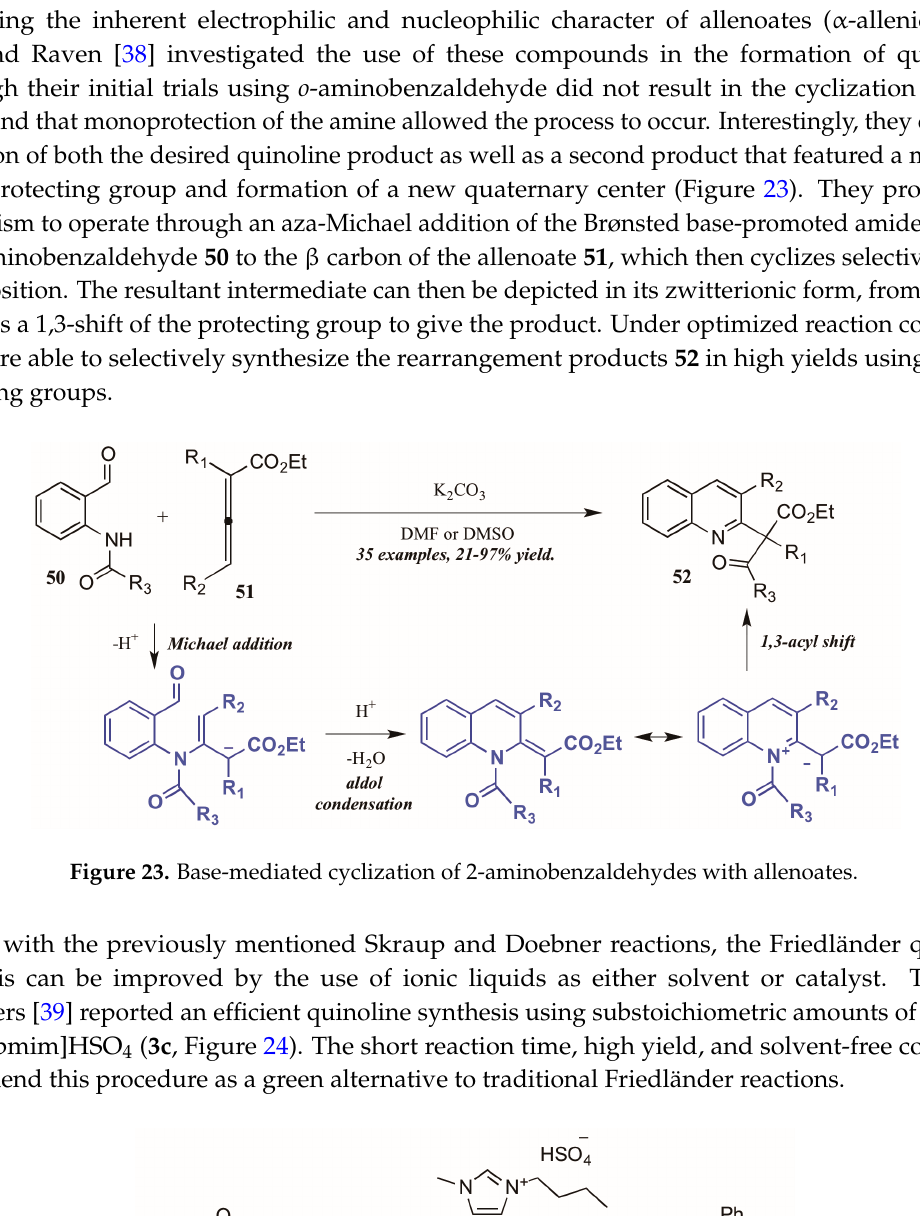
Figure 24. Ionic liquid-catalyzed Friedländer quinoline synthesis.